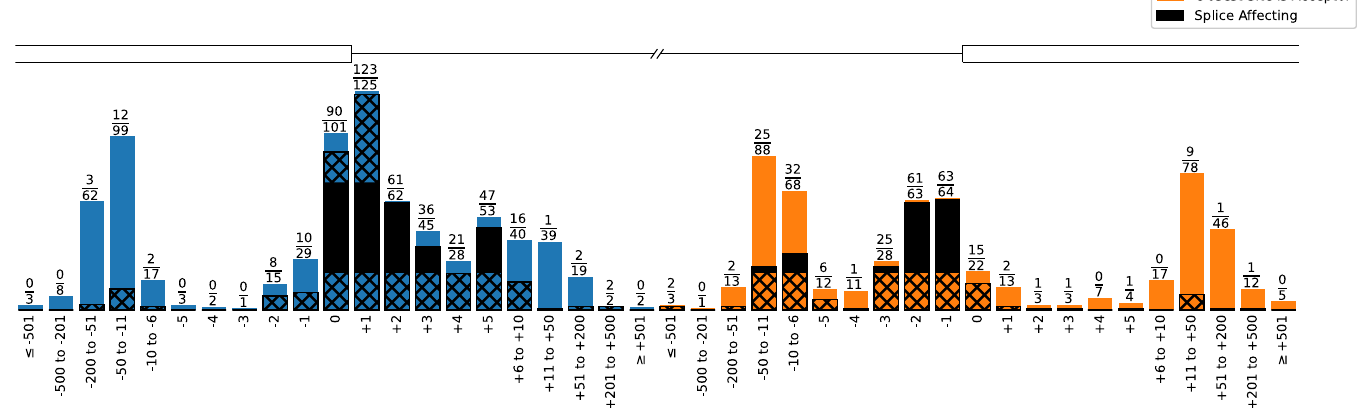
Fig 5. All 1,316 variants in relation to their closest splice site and if they affect splicing (shaded area and numerator in the fraction). 57% of sites are closer to a donor than an acceptor site. 23% of variants are in the consensus motif (equally split between acceptors and donors); 98% of variants within consensus regions are splice